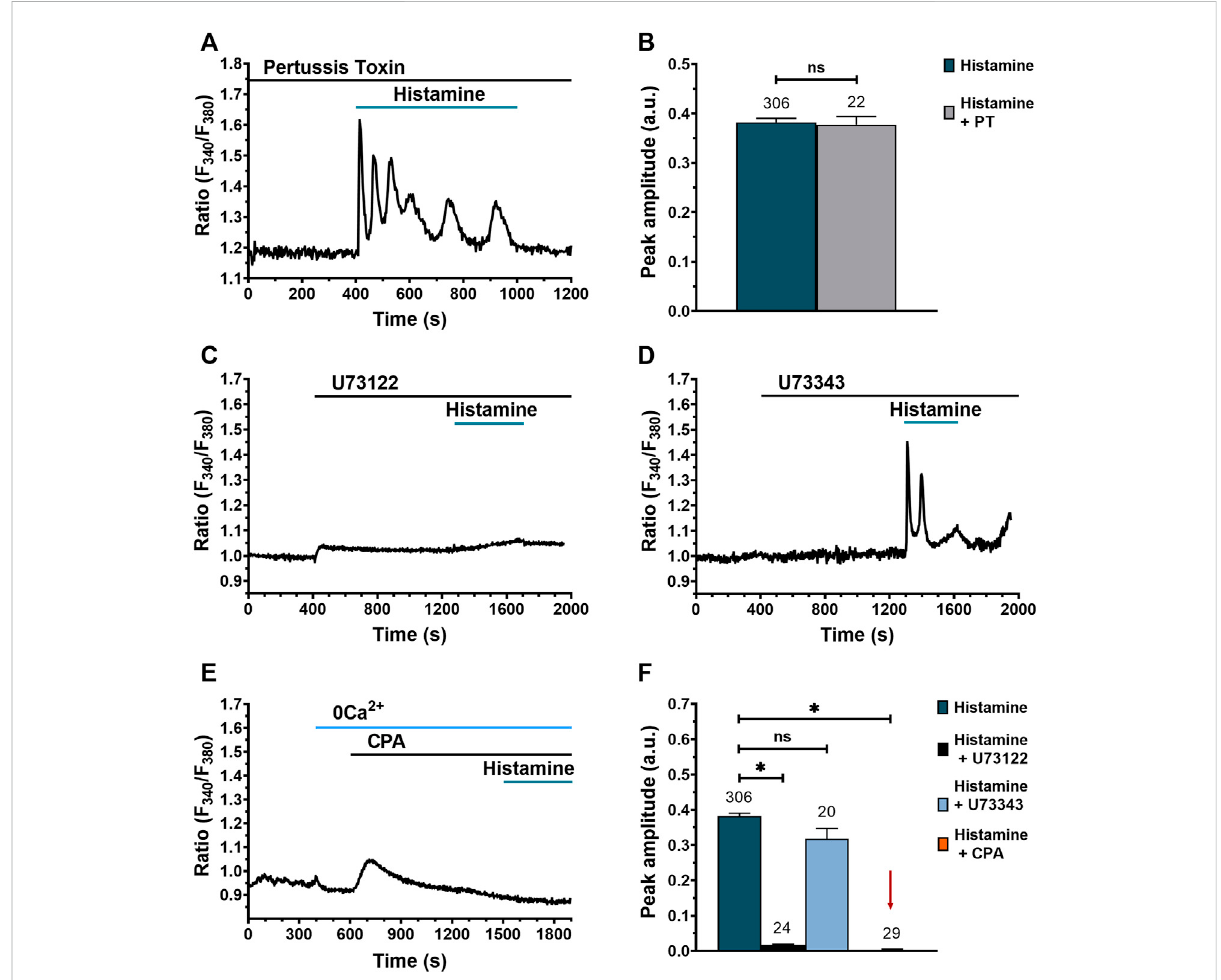
FIGURE 5 Histamine-evoked Ca 2+ signals in WI-38 human lung fi broblasts do not involve G α i/o activation but require PLC and ER Ca 2+ release. (A) Typical recordingoftheCa 2+ responsetohistamine(300 μ M)in fi broblastspreincubatedfor30 minwith100 ng/mlpertussistoxin(PT). (B) Mean±SEofthe peak amplitude of histamine-evoked Ca 2+ transients in the absence (green bar) and presence of pertussis toxin (gray bar). Comparison between groupswasperformedusingtheStudent ’ st-test(ns=nostatisticallyrelevantdifferencesbetweengroups). (C) Typicalrecordingoftheeffectof histamine (300 μ M) on Ca 2+ signal in cells pretreated for 15 min with U73122 (10 μ M), a speci fi c PLC inhibitor. (D) Typical recording of the Ca 2+ response to histamine(300 μ M)incells pretreated for 15 minwith U73343 (10 μ M), aninactive analogofU73122. (E) Representative recording ofthe Ca 2+ signal evoked by histamine(300 μ M) in cells pretreated with CPA (10 μ M) in the absence of extracellular Ca 2+ (0Ca 2+ ). (F) Mean ± SE of the peak Ca 2+ response to histamine (300 μ M; green bar) in the presence of U73122 10 μ M (black bar), U73343 10 μ M (blue bar) and CPA 10 μ M (orange bar not visible, marked with a red arrow). The numbers in the fi gure represent the number of cells studied. Statistical comparison between groups was performed using ANOVA test (* = p ≤